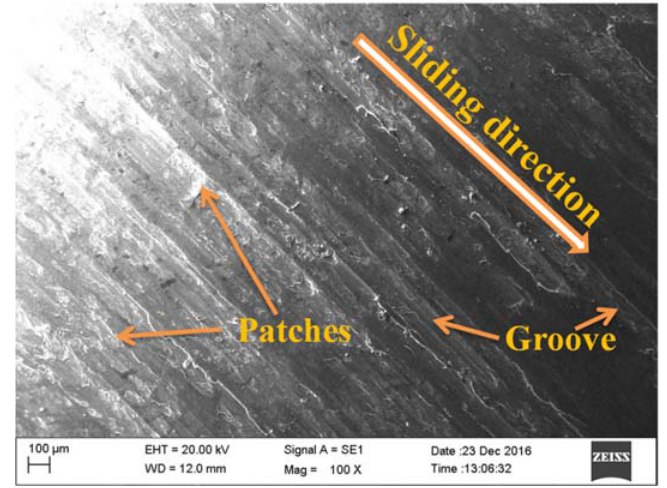
Figure 9: SEM image of the ice quenched (Al - 8 % of Al 2 O 3 - 8 % SiC)